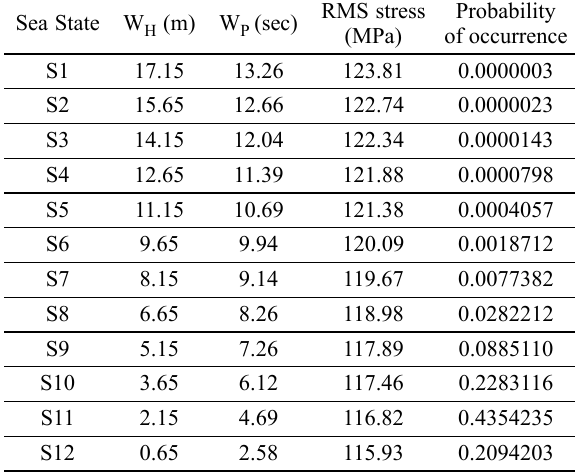
Table 1. Mechanical and Geometrical Properties of Spar-mooring system